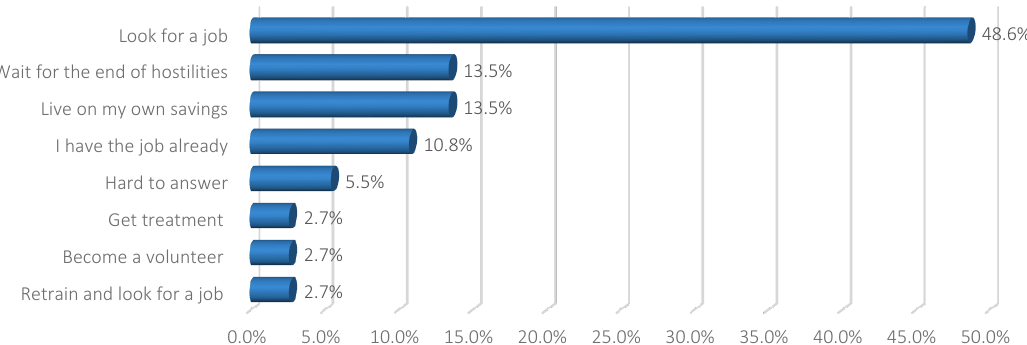
Figure 10. IDPs’ plans for the near future while staying in the Pidberiztsivska community, % of